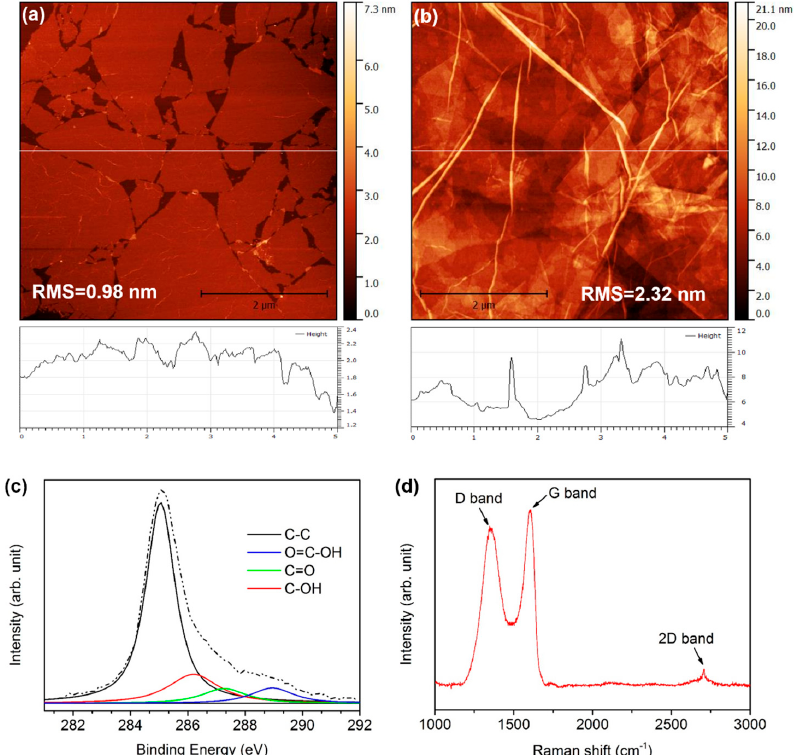
Figure 2. Atomic force microscopy (AFM) images of single-layer in situ thermal reduction grapheme oxide(S-ITR-GO) ( a ) and multi-layer ITR-GO (M-ITR-GO) ( b ); Raman spectrum ( c ) and X-ray photoelectron spectroscopy (XPS) spectra ( d ) of